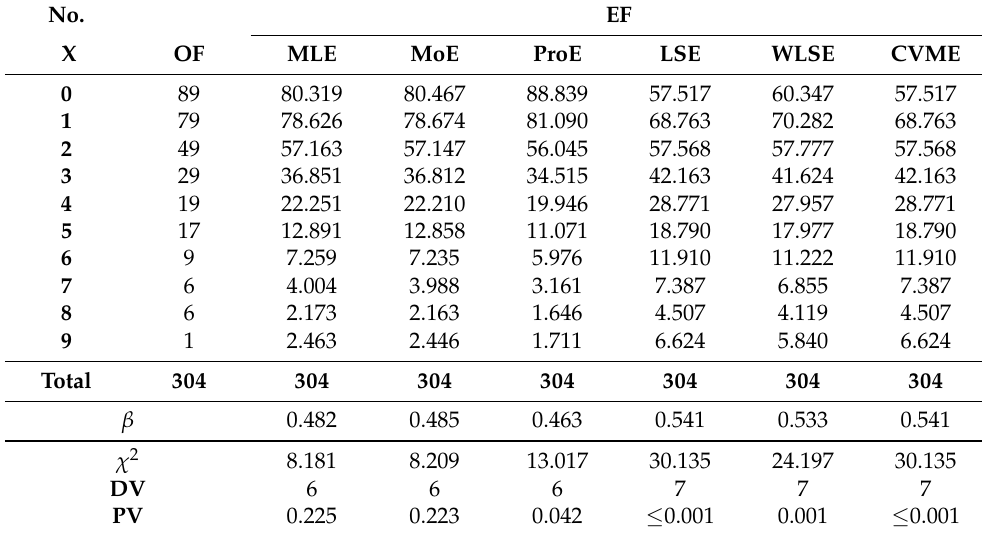
Table 13. CVE for data set III.